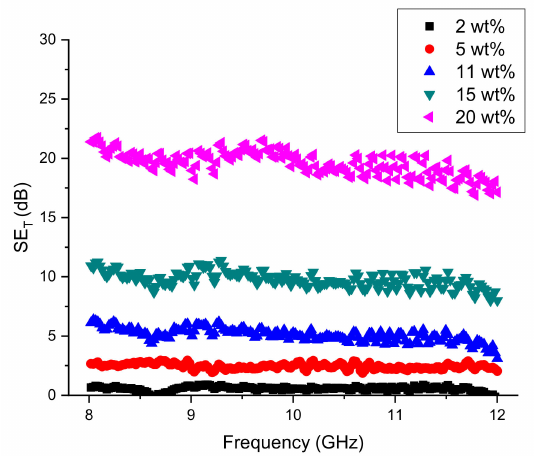
Figure 8. Total shielding efficiency of CH/Na/CuSe polymer matrix with 2 wt% to 20 wt% of CuSe